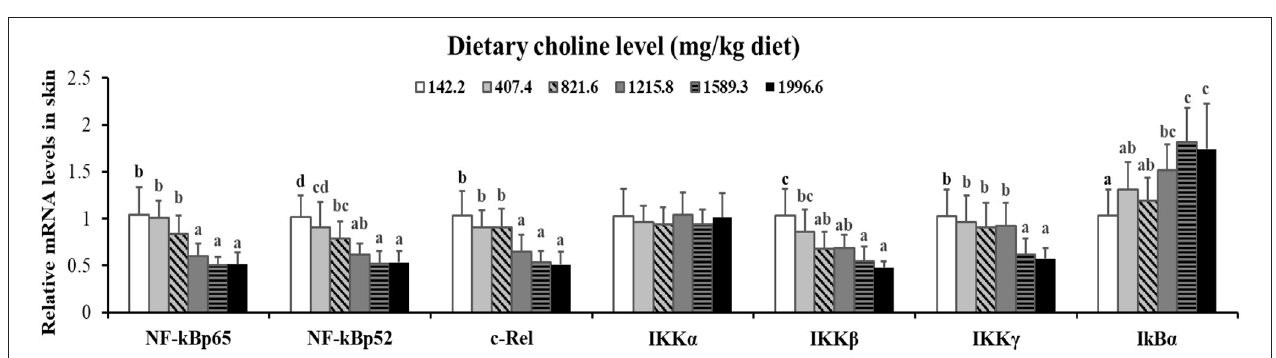
FIGURE 3 | Effects of dietary choline on parameter mRNA levels in the skin of grass carp after infection with A . hydrophila . This analysis was repeated six times with similar results. Data represent means of six fish in each group, and error bars indicate S.D. Values having different letters are significantly different ( P < 0.05). (A) Relative mRNA level of Hepcidin, β -defensin-1, Mucin2, LEAP-2A, and LEAP-2B in the skin. (B) Relative mRNA level of pro-inflammatory cytokines in the skin. (C) Relative mRNA levels of anti-inflammatory cytokines in the skin.